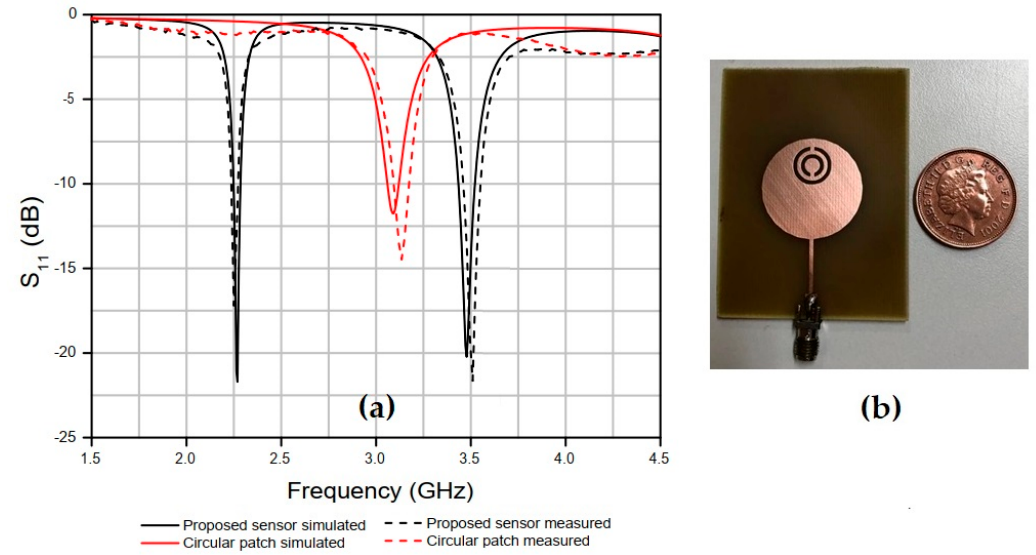
Figure 2. ( a ) Simulated and measured results of the reflection coefficient, S 11 (dB), of the circular patch antenna and the proposed sensor with the double complementary split-ring resonator (CSRR) element; ( b ) photograph of the proposed sensor antenna.